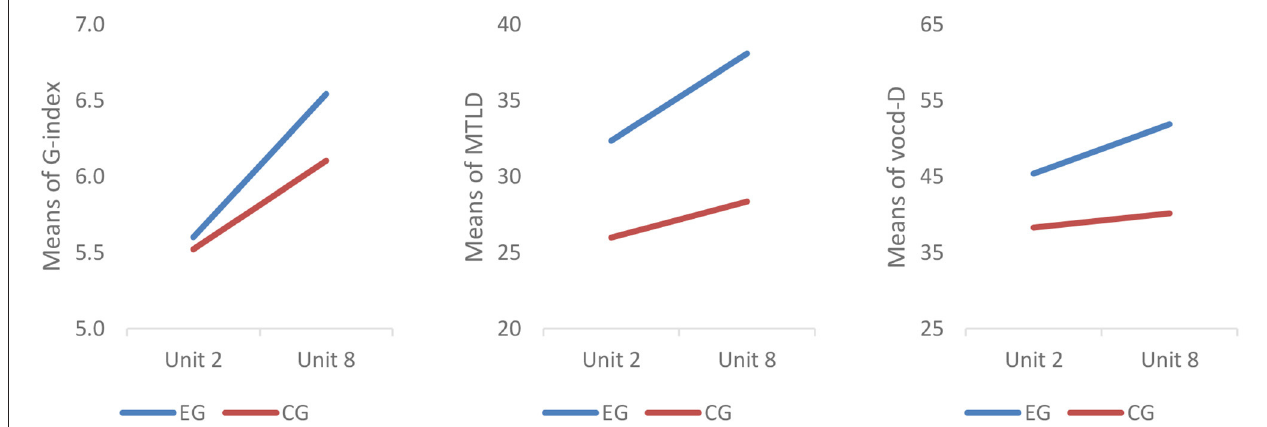
FIGURE 5 | Profile plot of lexical diversity metrics. Covariates appearing in the model are evaluated at the following values: placement test score = 83.05.